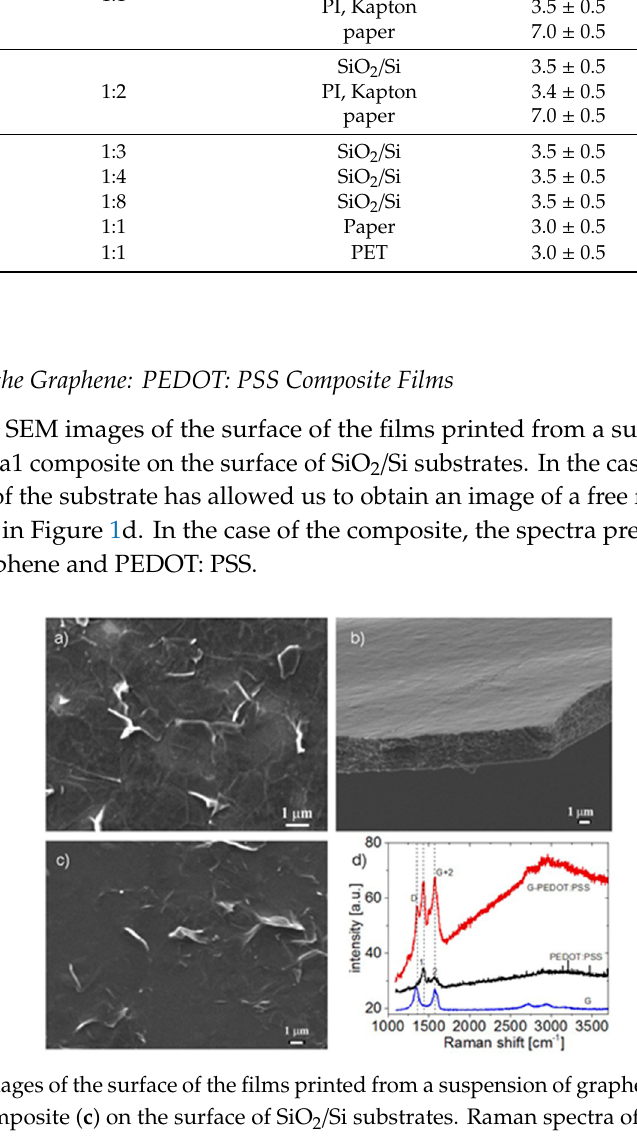
Table 1. Nomenclature and characteristics of the structures prepared from the graphene: PEDOT: PSS composite material. R / R o is the response of humidity sensor, R / R o = (R(high humidity) − R o (low